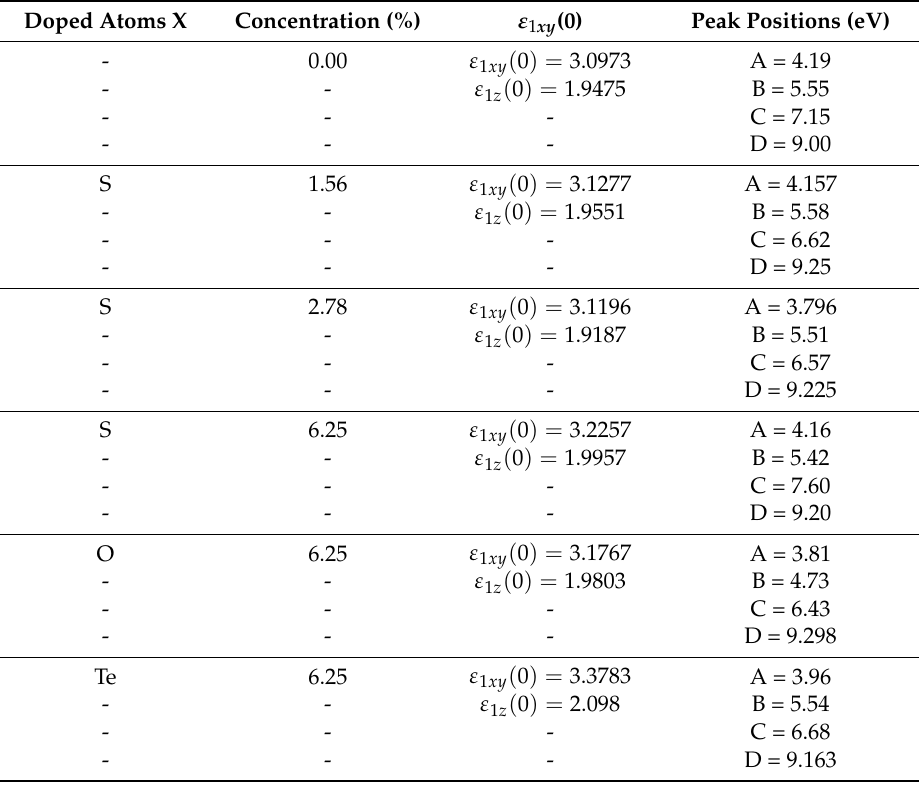
Table 4. Static dielectric constant ε 1 ( 0 ) , peak values of imaginary part ε 2 ( ω ) for monolayer CSe with and without